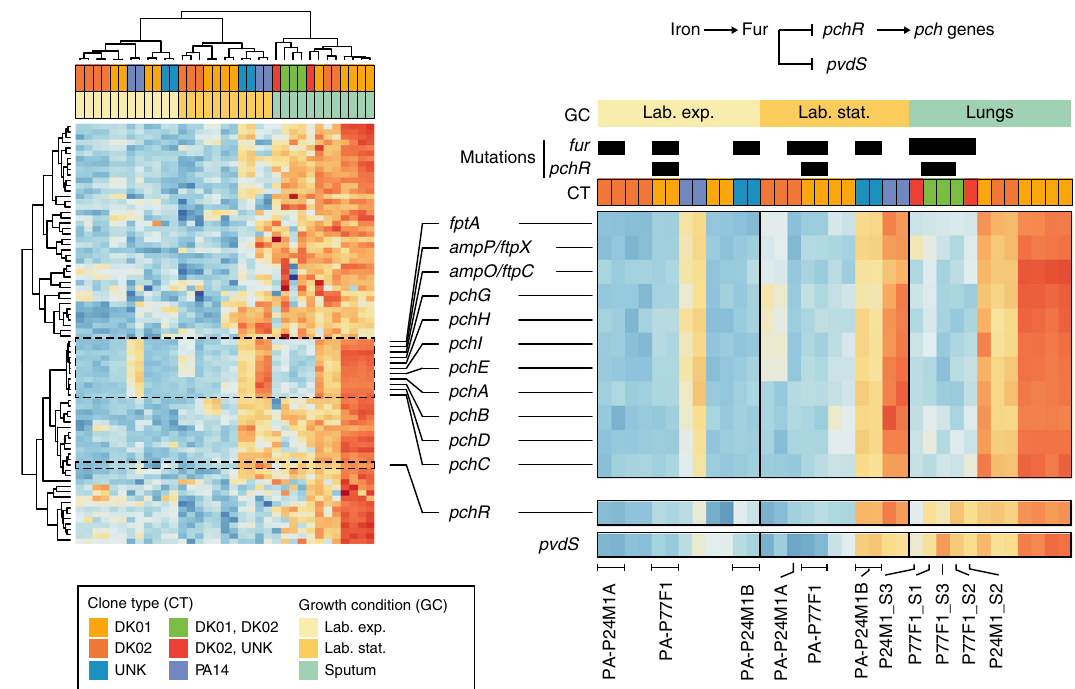
Fig. 5 Transcriptional patterns of differentially expressed genes involved in iron acquisition and metabolism. Heat maps report the intensity of expression of each gene (rows) expressed as log-regularized read counts and scaled for each row. Each column represents a sample analyzed and is clustered based on the result of pvclust analysis. Growth conditions, clone type of each sample, presence of genetic mutations in fur and pchR genes (black bars), and a schematic representation of the regulation of pyochelin operon are